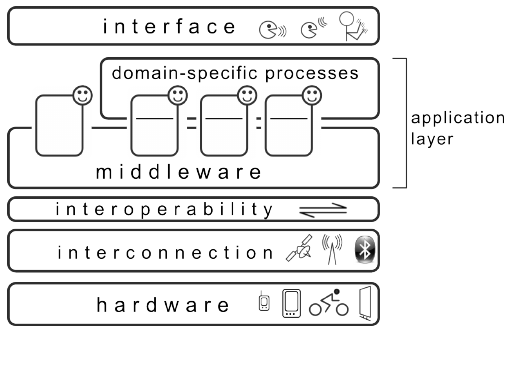
Figure 1. A layered perspective on the AmIciTy platform, featuring agents that are part of the context-aware middleware, but may also contain application-specific behaviors. The architecture has been introduced in previous work